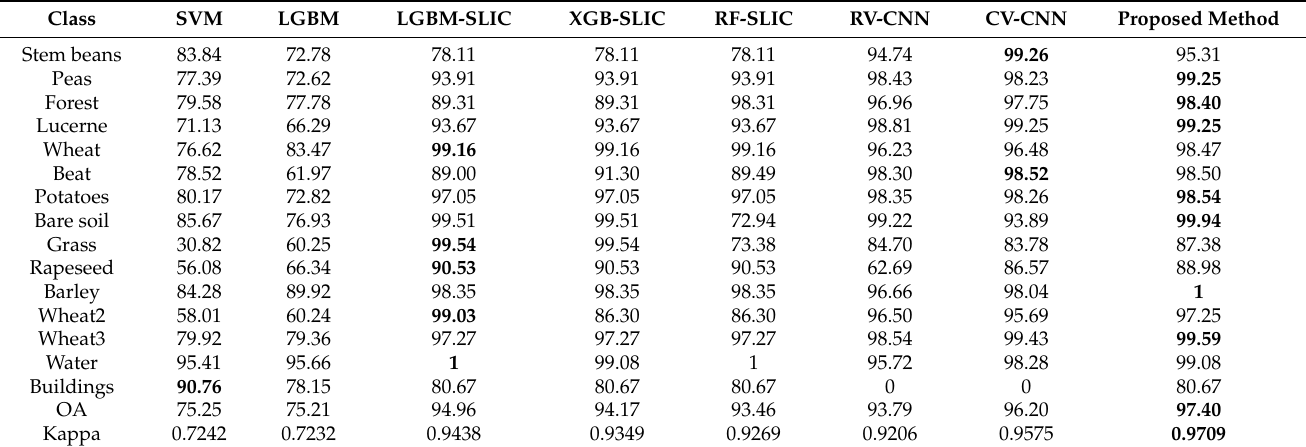
Table 2. Accuracy results of Flevoland